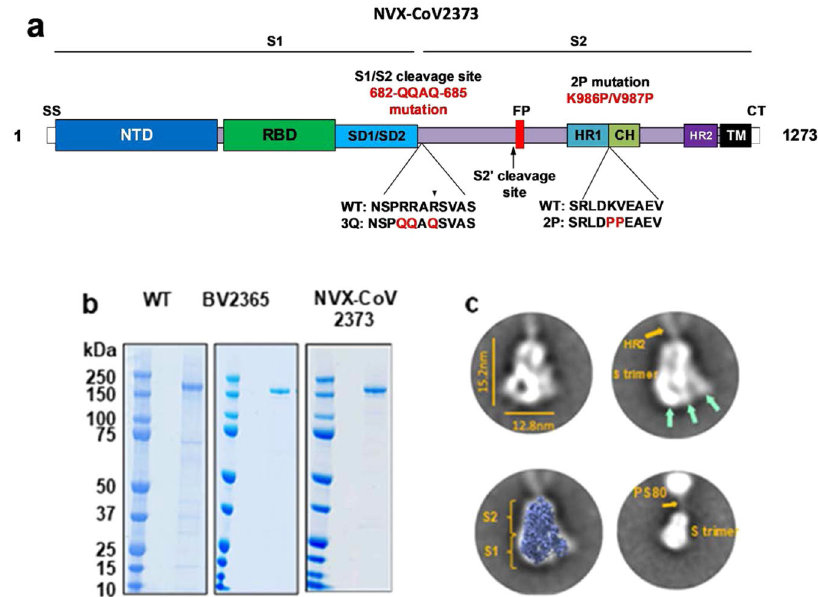
Fig. 1 SARS-CoV-2 spike glycoprotein constructs. a Linear diagram of the full-length SARS-CoV-2 spike (S) protein showing the S1 and S2 subunits. Structural elements include a cleavable signal sequence (SS, white), N-terminal domain (NTD, dark blue), receptor binding domain (RBD, green), subdomains 1 and 2 (SD1/SD2, light blue), fusion peptide (FP, red), heptad repeat 1 (HR1, yellow), central helix (CH, light green), heptad repeat 2 (HR2, purple), transmembrane domain (TM, black), and cytoplasmic tail (CT, white). The native furin cleavage site was mutated (RRAR → QQAQ) to be protease resistant to generate the full-length BV2365 variant. BV2365 was further stabilized by introducing two proline (2P) substitutions at positions K986P and V987P to produce the double mutant NVX-CoV2373. b Reduced SDS-PAGE gel of puri fi ed full-length wild-type (WT), BV2365, and NVX-CoV2373 (representative of 3 to 10 lots). WT spike is produced as a mixture of cleaved and uncleaved proteins. Figure shows puri fi ed uncleaved WT spike protein. c Transmission electron microscopy and 2D class averaging of NVX-CoV2373. 2D images were constructed from 28,623 NVX-CoV2373 particles followed by two rounds of 2D averaging. 2D images of NVX-CoV2373 S-trimers showing well-de fi ned triangle-shaped particles with a length of 15 nm and a width of 12.8 nm. The S1 apical surface with the N-terminal receptor and receptor-binding domain (NTD/RBD) is indicated by green arrows. Faint protrusions (orange arrow) extending from the tip of the trimers were evident and appear to correspond to the S2 HR2 domain. Class average images showing a good fi t of NVX-CoV2373 S-trimer with cryoEM solved structure of the SARS-CoV-2 trimeric spike protein ectodomain (EMD ID: 21374) overlaid on the 2D image. 2D class averaging using a larger box size showing 2D class average image with the less well-de fi ned HR2 (orange arrow) anchoring the S-trimer to polysorbate 80 (PS80) micelle by the C-terminal TM. Source data are provided as a Source Data fi le. at pH extremes (48 h at pH 4 and pH 9), with prolonged agitation Table 1 Particle size and thermostability of SARS-CoV-2 (48 h), through freeze/thaw (two cycles), or elevated temperature trimeric spike (48 h at 25 °C and 37 °C) had no effect on hACE2 receptor binding (IC 50 = 14.0 – 18.3 ng mL − 1 ). Only oxidizing conditions with hydrogen peroxide reduced the binding of NVX-CoV2373 by eightfold (IC 50 = 120 ng mL − 1 ) (Fig. 3a). BV2365 without the two proline substitutions was less stable as determined by a signi fi cant reduction in hACE2 binding (IC 50 = 56.8 – 143.4 ng mL − 1 ) under CoV2373 with the two proline mutations had signi fi cantly greater stability and was therefore selected for further evaluation.